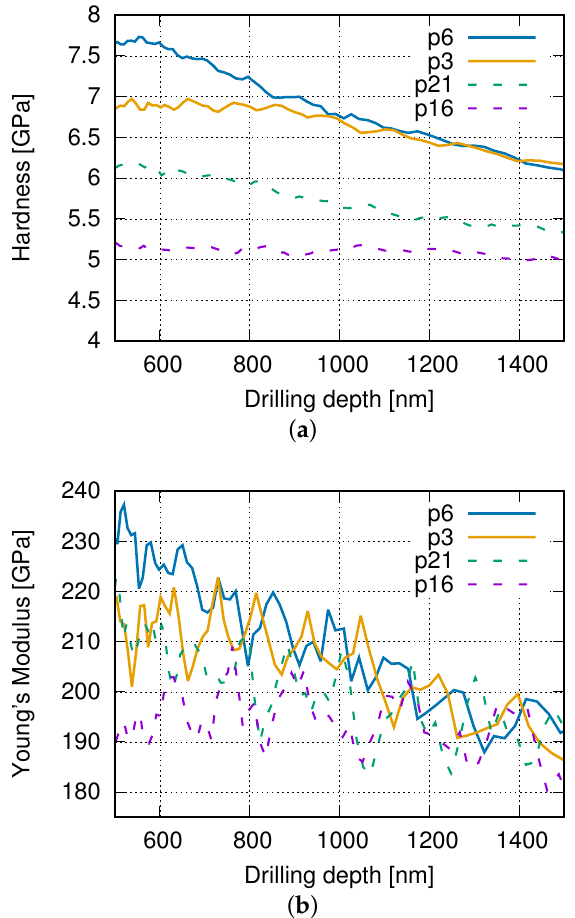
Figure 7. Measured values according to the drilling depth from HV0.3 nanoindentation tests after graphitization of diamonds (type-II quasi-brittle behavior, point number shown in Figure 6d): ( a ) hardness; ( b ) Young’s